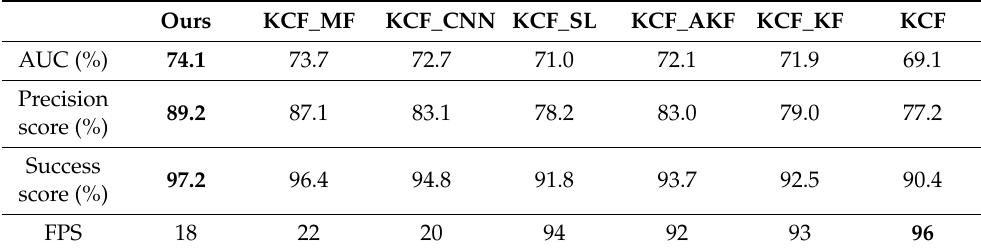
Table 3. The experimental ablation results of all occluded video sequences (in bold the optimal re- sults per tracker).